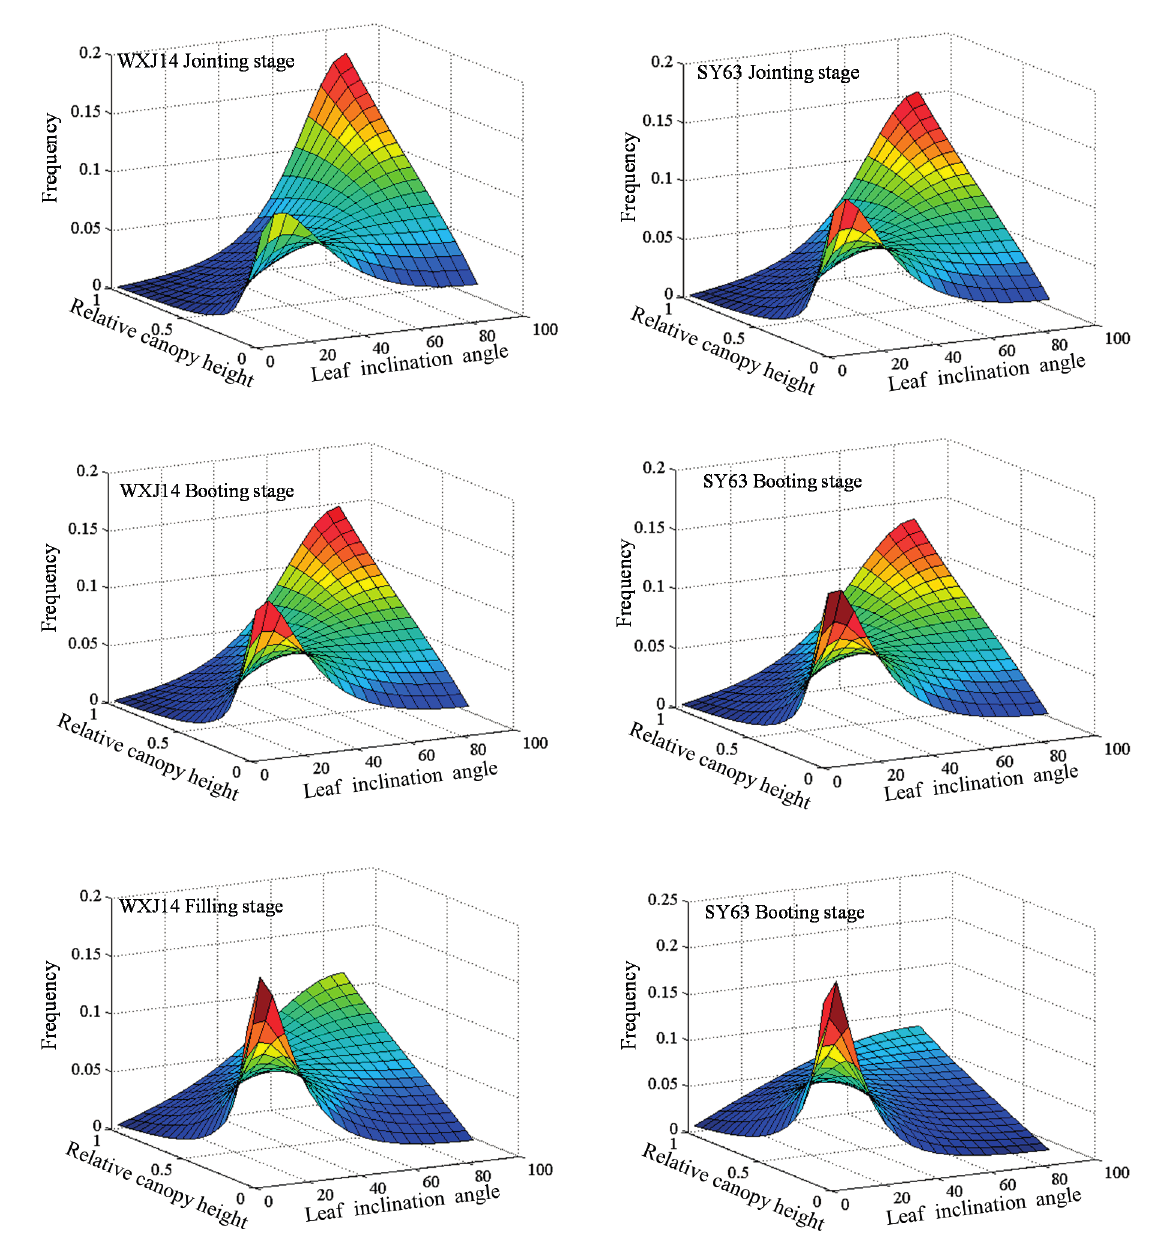
Figure 8. Frequency of leaf angle distribution of different canopy layers of rice at the jointing, booting and filling